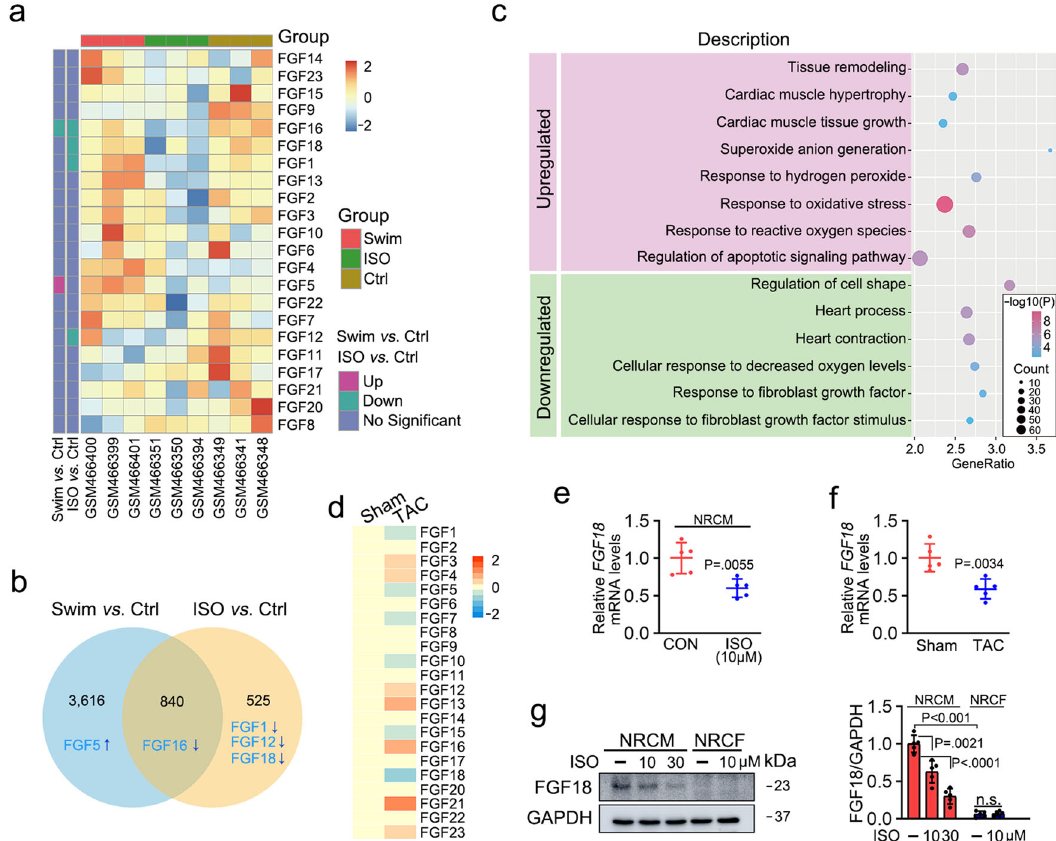
Fig. 1 | Identi fi cation of the candidate FGFs-related genes in pathological myocardial hypertrophy. a – c The results were from the analysis of the GSE18801 dataset. a ThecorrespondingFGFsof the5genes correlatedwiththephysiological and pathological myocardial hypertrophy were visualized by the heatmap in the normal,swim, and isoproterenol(ISO)treatment samples. The darkershadeofred or blue represents the higher correlation level. b Venn diagram visualizing the myocardial hypertrophy-related differentially expressed genes between swim and ISO treatment. c KEGG enrichment analysis of the in fl uence of pathological myo- cardial hypertrophy genes after ISO treatment. The y-axisrefers to pathwayterms. Thex-axisistherich factor. d Apro fi leofthemRNAexpression of FGFs inShamor transverse aortic constriction (TAC)-operated mouse heart at 6 weeks. Heatmap